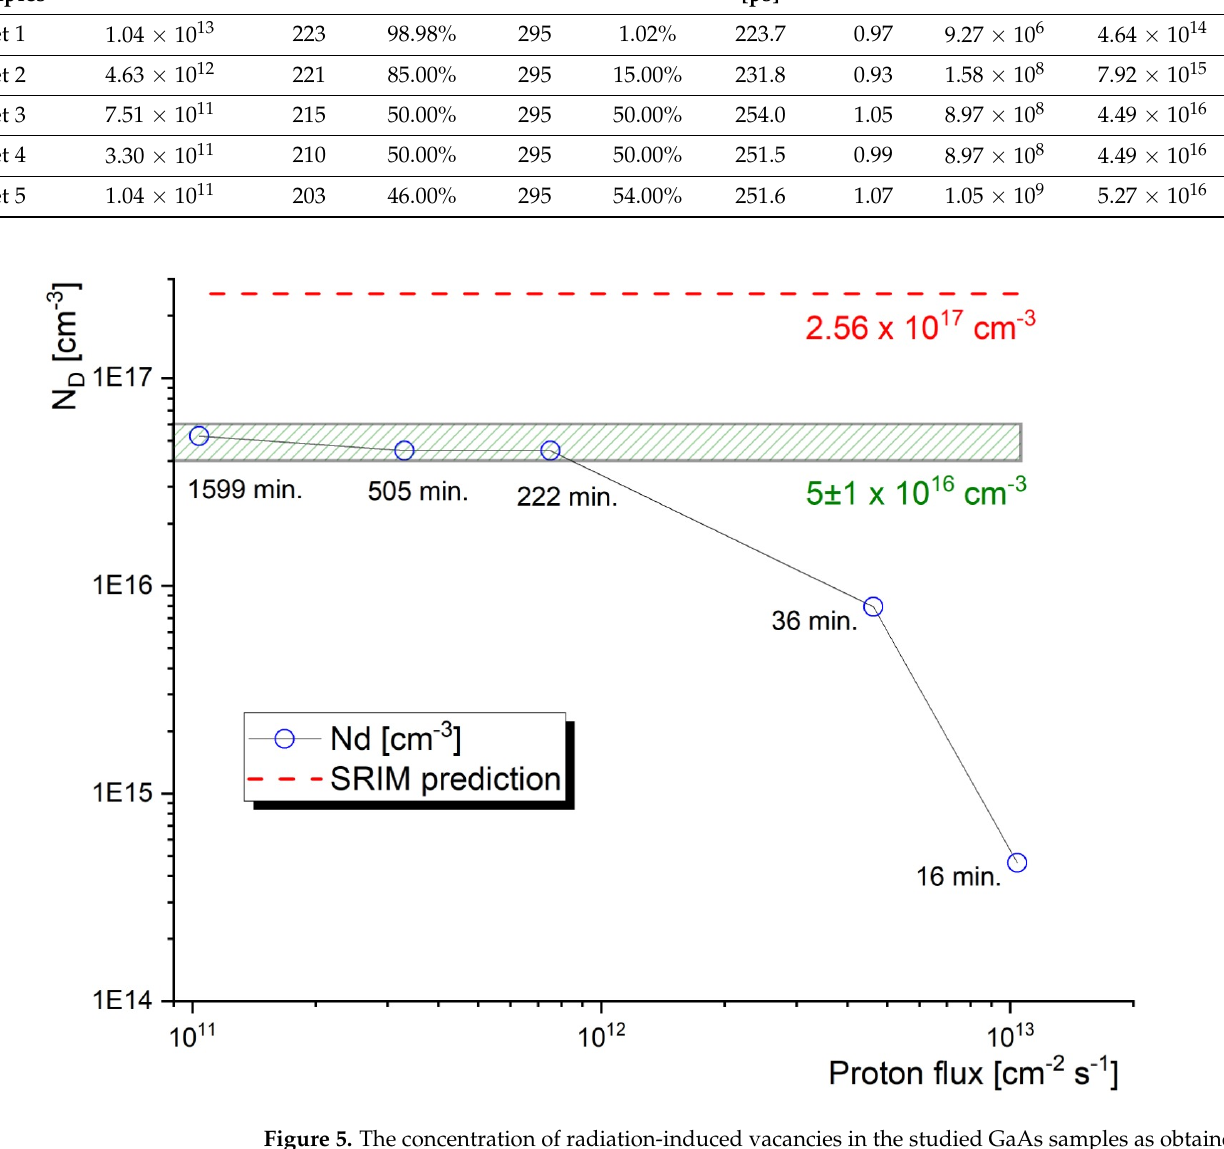
Figure 5. The concentration of radiation-induced vacancies in the studied GaAs samples as obtained from the PALS experiments. The concentration predicted by SRIM for 0 K is also indicated.